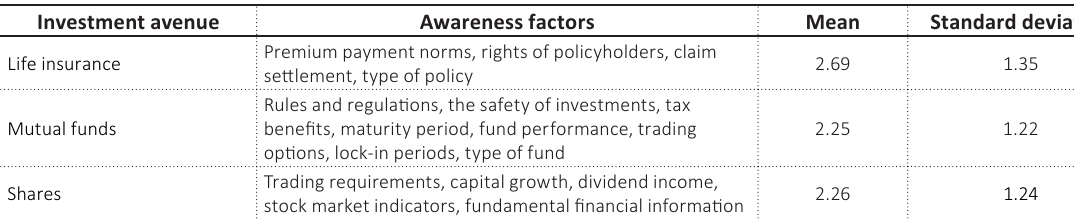
Table 6. Aggregate awareness level of investment